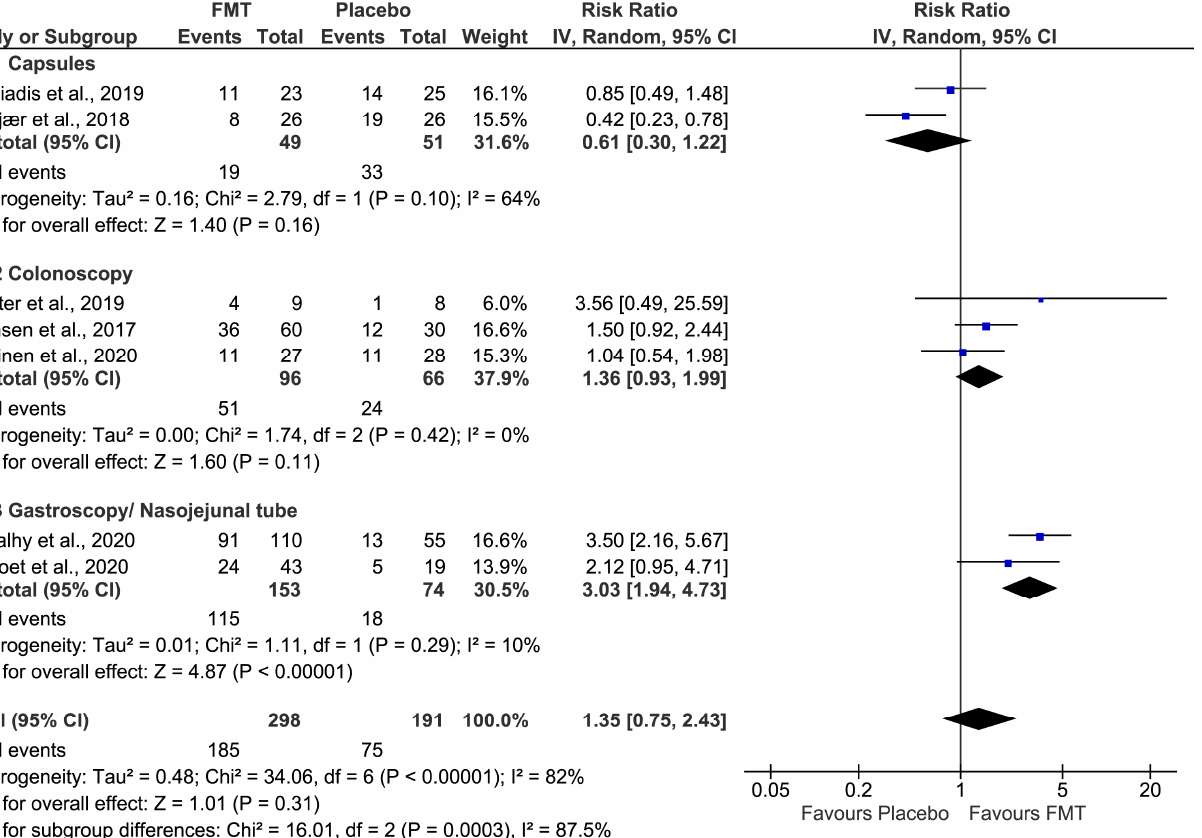
Figure 3. Forest plot for efficacy of FMT vs placebo on global improvement of IBS symptoms by delivery method. Aroniadis et al., 2019 [31] , El-Salhy et al., 2020 [32] , Halkjær et al., 2018 [33] , Holster et al., 2019 [34] , Holvoet et al., 2020 [35] , Johnsen et al., 2017 [36] and Lahtinen et al., 2020 [37] .